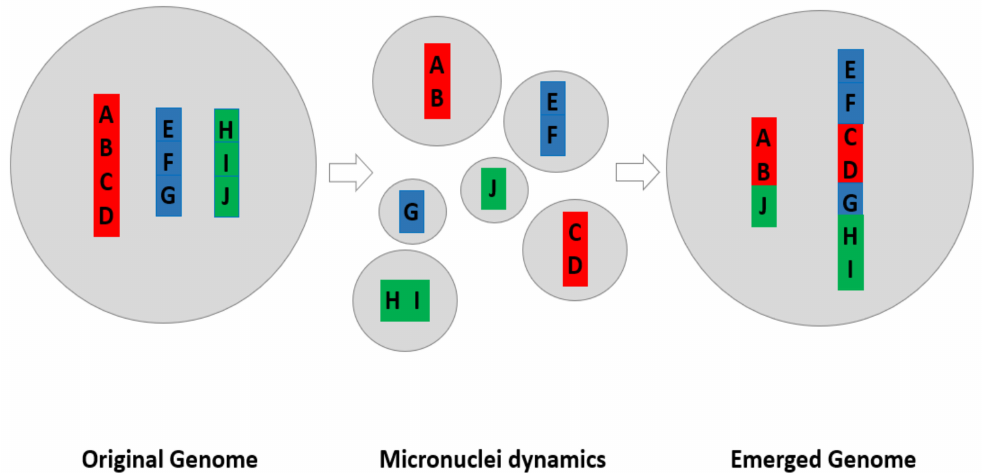
Figure 2. The diagram of how micronuclei create a new genome by re-organizing karyotype coding. When under stress (either internal or environmental), the cluster of micronuclei is formed, which can either lead to death, proportional survival (partial population survival without altering the genome), form an emergent genome through fusion / fission cycle, or simply combine with other